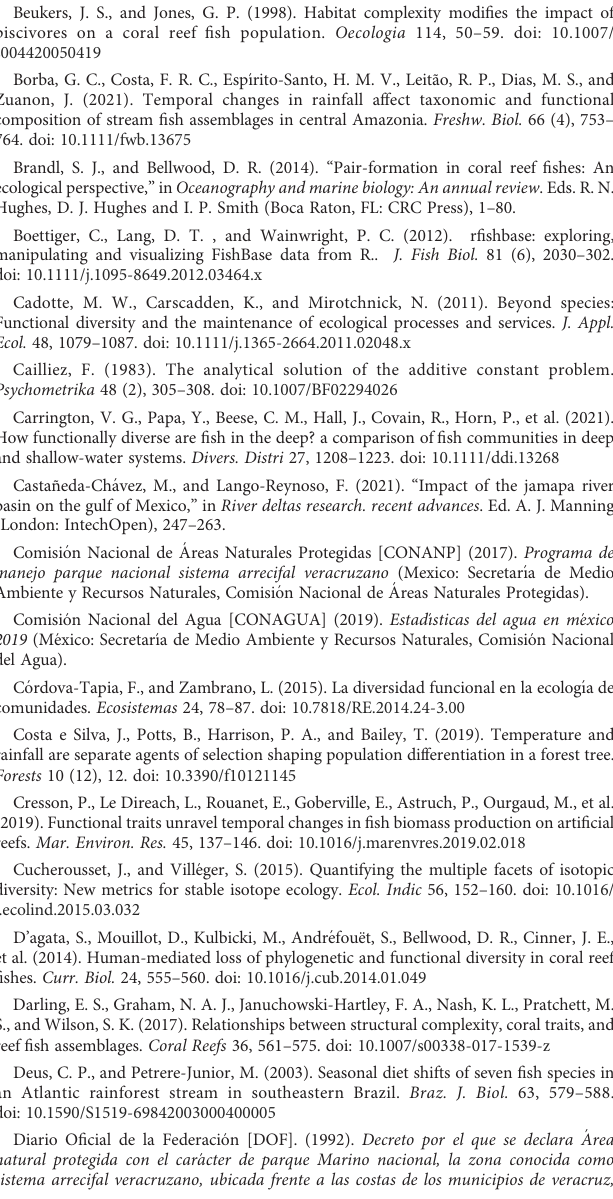
SUPPLEMENTARY TABLE 2 Listof speciesverticesshapingtheconvex hullof149reef fi shspecies presentin Parque Nacional Sistema Arrecifal Veracruzano between 2006 and 2021. SUPPLEMENTARY FIGURE 1 Cartoon scheme shows hierarchical sampling design of Parque Nacional Sistema Arrecifal Veracruzano between 2006 and 2021. Both subsystem (north and south) was sampled at two different seascapes (inner shelf and outer shelf). The observations in reefs at different seascapes were made at two depth levels (shallows and deep).